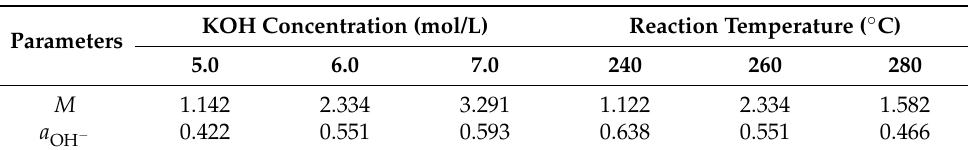
( a ) and ln K 0 − 1/T ( b OH −